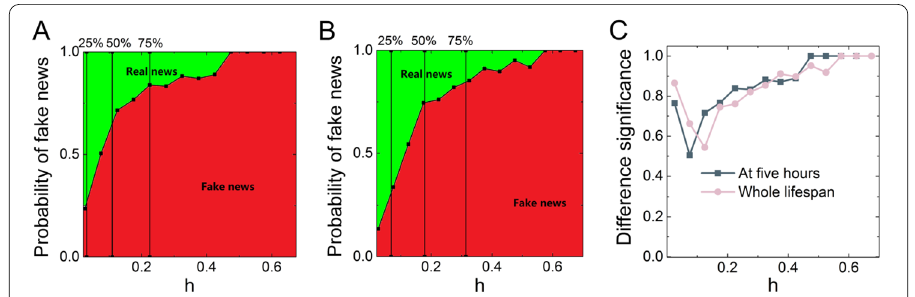
Figure 6 The heterogeneity measure shows a high difference between fake news and real news of Weibo in its early stage of propagation. ( A ) Probability of being fake news at five hours. The three vertical lines divide the figure into four parts with an equal number of networks. For example, the area on the left of the first left line has 25% of all the Weibo propagation networks. ( B ) Probability of being fake news for the whole lifespan. ( C ) The difference significance between fake news and real news